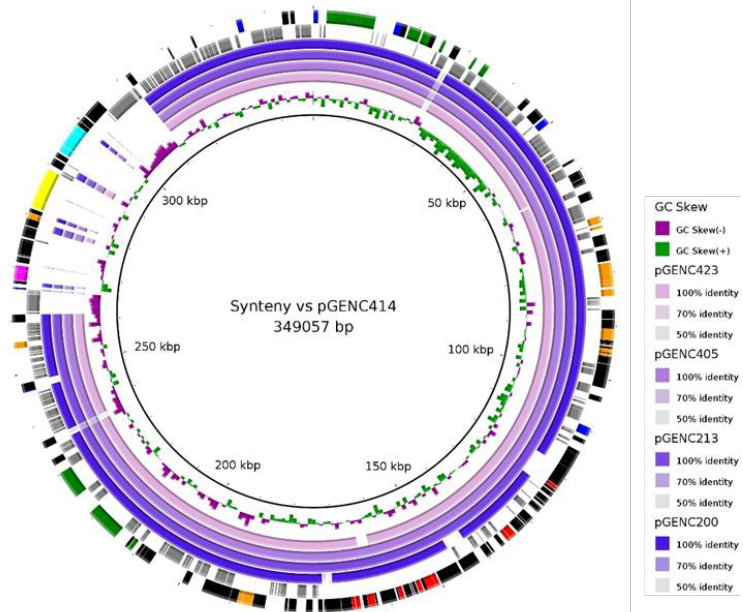
Figure 3. Syntenic analysis of five bla CTX-M-15 /IncHI2/ST1 plasmids from the UHCG. This figure was developed with BRIG software. The first black ring represents the pGENC414 plasmid, used as the reference, and the second ring indicates the GC skew. This first plasmid was isolated from the E. cloacae complex taxon 4 ST1503 (GenBank accession number OL331020, recovered in July 2019). The inner to the outer rings correspond to the following pairwise comparison with IncHI2/ST1 plasmids from other ECC STs isolated at the same hospital: pGENC423 ( E. cloacae , ST167, OL331021, August 2019), pGENC405 ( E. asburiae , ST53, OL331019, May 2019), pGENC213 ( E. xiangfangensis , ST113, OL331018, November 2018) and pGENC200 ( E. xiangfangensis , ST114, CP061495, October 2018). The last rings represent the genetic map of pGENC414, with the first hypothetical proteins shown as grey arrows, followed by coding sequences in black arrows, except for genes associated with antibiotic resistance (red), conjugation (green), formaldehyde detoxification (fuchsia), heavy-metal resistance (orange), Fe(III) transporter system (yellow), lac operon (aqua) and plasmid replication, partition or maintenance (blue). The genetic details and metadata of the plasmids are shown in Supplementary Data Set